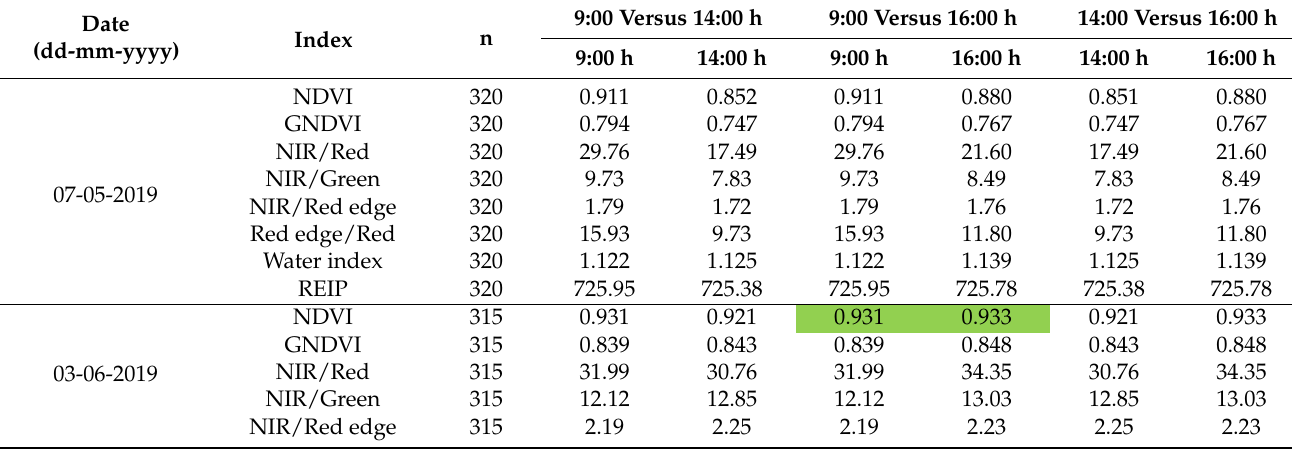
Table 7. Mean values of each vegetation index for paired measurement times (9:00 versus 14:00 h, 9:00 versus 16:00 h, and 14:00 versus 16:00 h) measured with the handheld hyperspectral bidirectional HandySpec Field sensor on each date of measurement. Green shading indicates non-significant differences between paired measurement times using t -Tests; all other pairs were statistically different ( p < 0.016, corrected by Bonferroni for multiple comparisons).